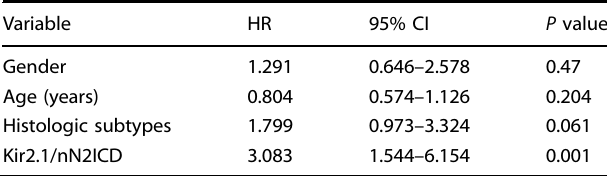
Table 3. Multivariate analysis of OS in non-WNT/SHH MB